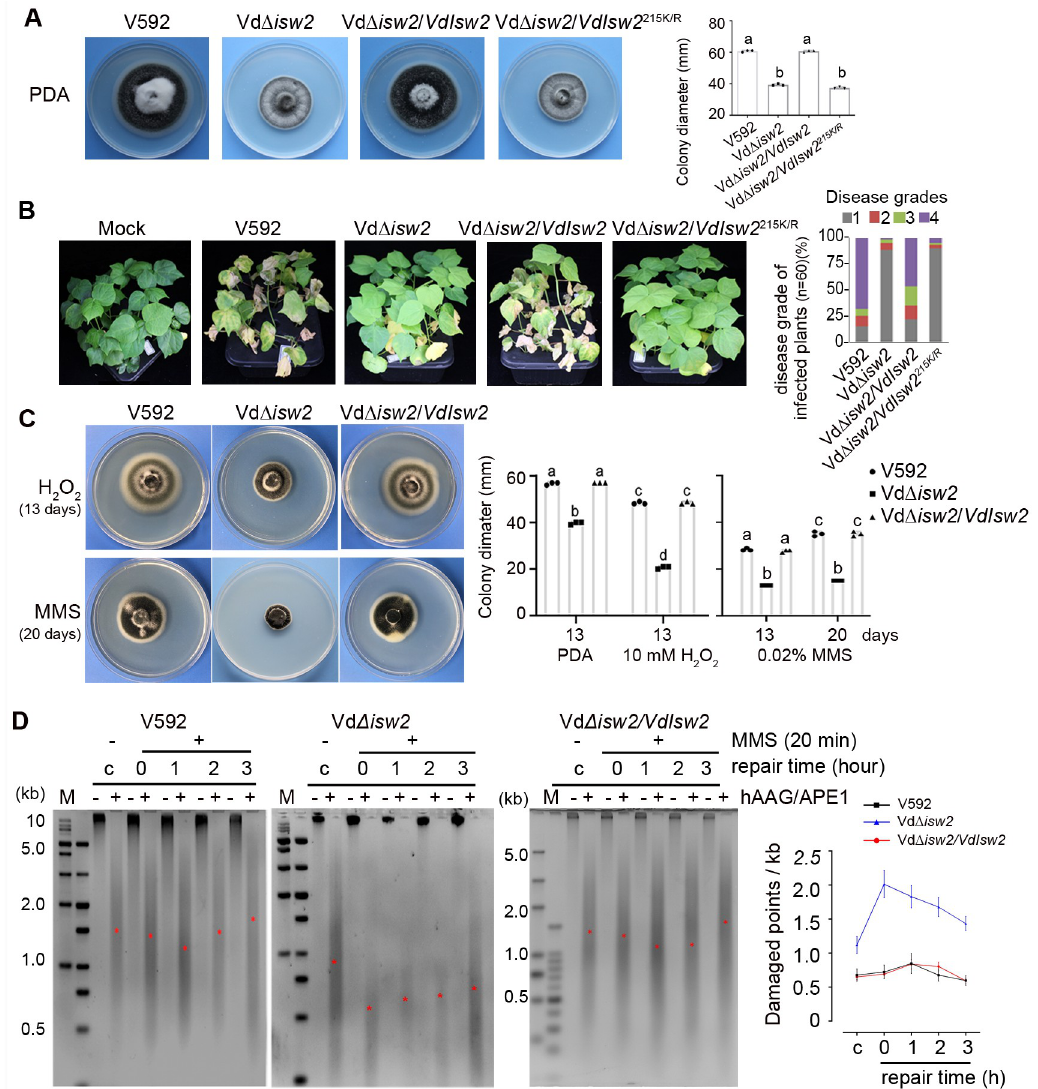
Fig 5. VdIsw2 is required for development, DNA damage repair and pathogenicity. A. Colony morphology of wild-type V592, the Vd Δ isw2 mutant strains, the Vd Δ isw2/VdIsw2 complementation strains, and the Vd Δ isw2/VdIsw2 215K/R strains on PDA plates after 2 weeks postincubation. Quantification of colony diameter is shown on the right. Different letters indicate significant differences of fungal growth ( P < 0.05, t-test, mean ± SD). B. Disease symptoms of cotton plants infected with V592, the Vd Δ isw2 mutant, Vd Δ isw2/VdIsw2 , and Vd Δ isw2/VdIsw2 215K/R strains at 30 dpi. Disease grades were calculated as Fig 1. C. Quantification of colony diameter cultured on PDA media with H 2 O 2 and MMS. Different letters indicate significant differences of fungal growth at P < 0.05, mean ± SD, one-way analysis of variance (ANOVA) followed by Tukey’s multiple comparisons test. D. The depletion of VdIsw2 dramatically inhibited genome-wide BER. A representative gel showing the repair time course in WT, the Vd Δ isw2 mutant and complementation Vd Δ isw2/VdIsw2 strains. M: marker DNA size standard; c: untreated cells; 0–3: cells damaged with MMS for 20 min; 1–3: repair time course in hours. Positions of the approximate median migration distance of the fragments in each lane are shown with red asterisks ( � ). The number of damaged DNA for each kilobase was calculated according to the average length obtained from the median migration distance. Error bars represent standard deviations from three independent